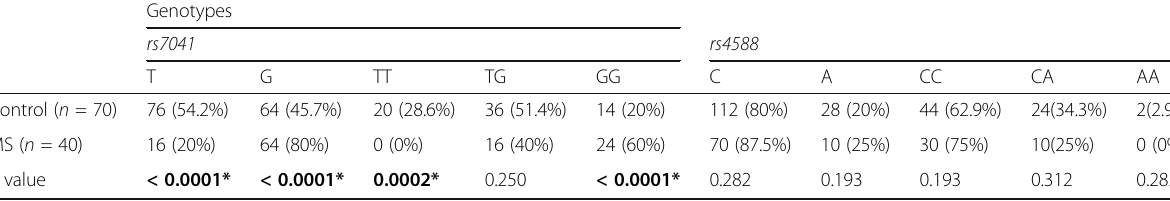
Table 1 Distribution of DBP gene genotypes variations Genotypes